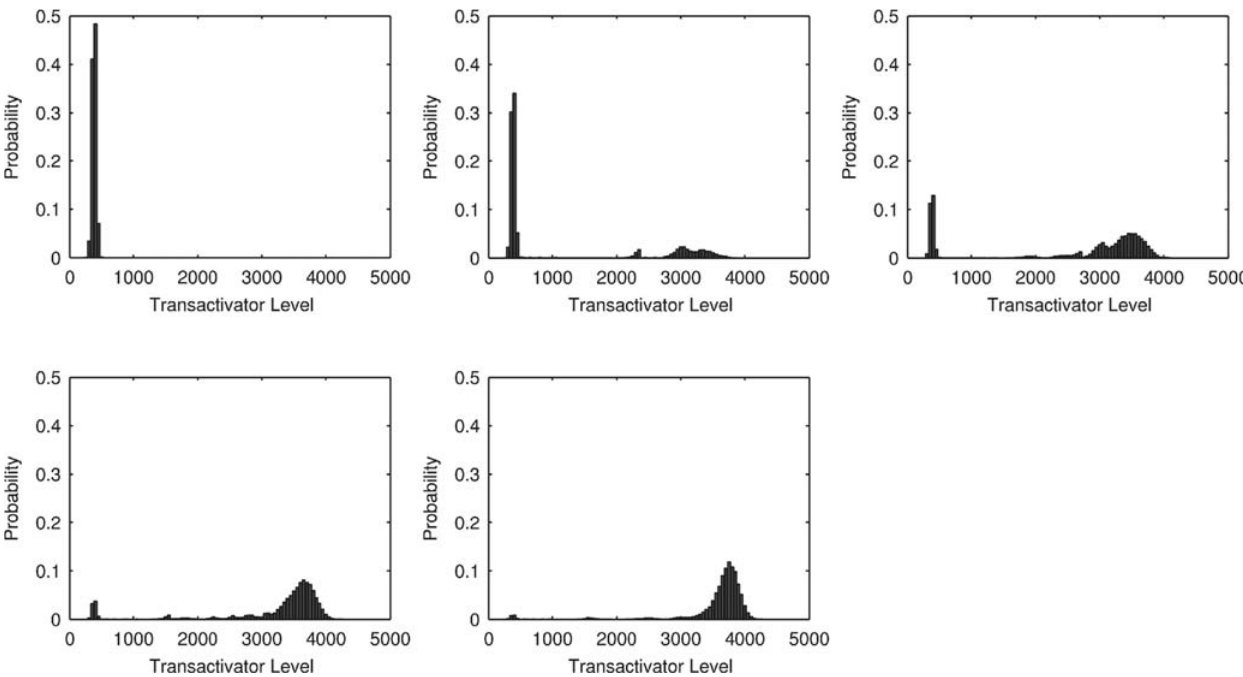
Figure 3. Simulations of the expression behaviour of the positive feedback loop. The simulations based on the Gillespie algorithm were run as described in the text. Increasing concentrations of Dox (0, 0.5, 1, 1.5 and 2.5 m g/mL) were applied as indicated. The resulting transactivator molecule counts were monitored. The population histograms show the probability of a respective transactivator level. The system parameters were k on =20, k off =20, sA=50, sR=5, sP=0.2, d M =0.1, d P =0.05, k + =20 and k 2 =10.